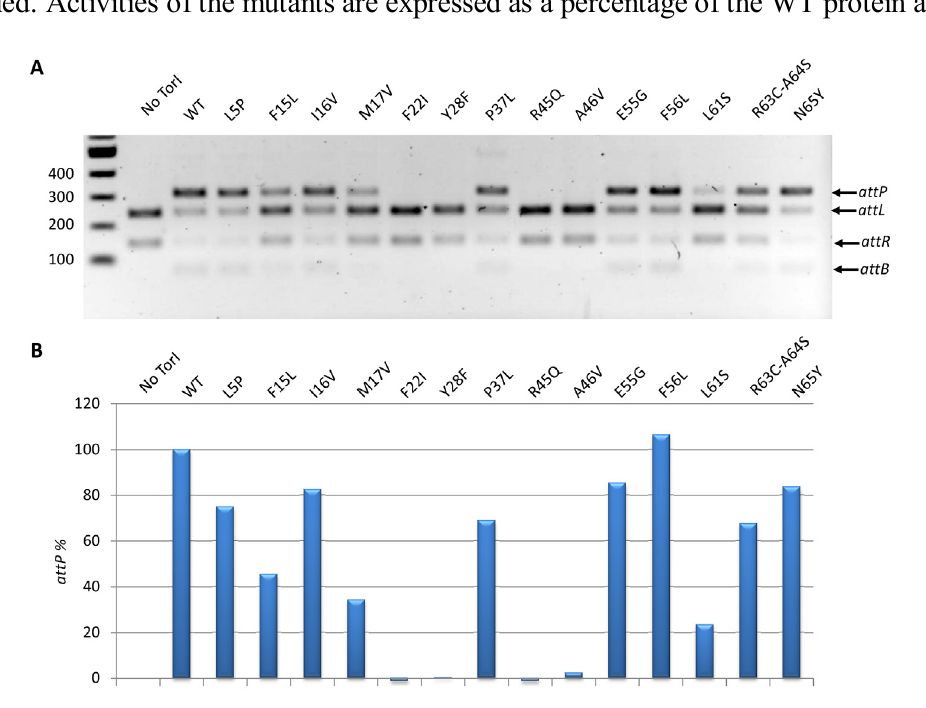
Figure 4. In vitro excisive recombination assay. Reactions were conducted as indicated